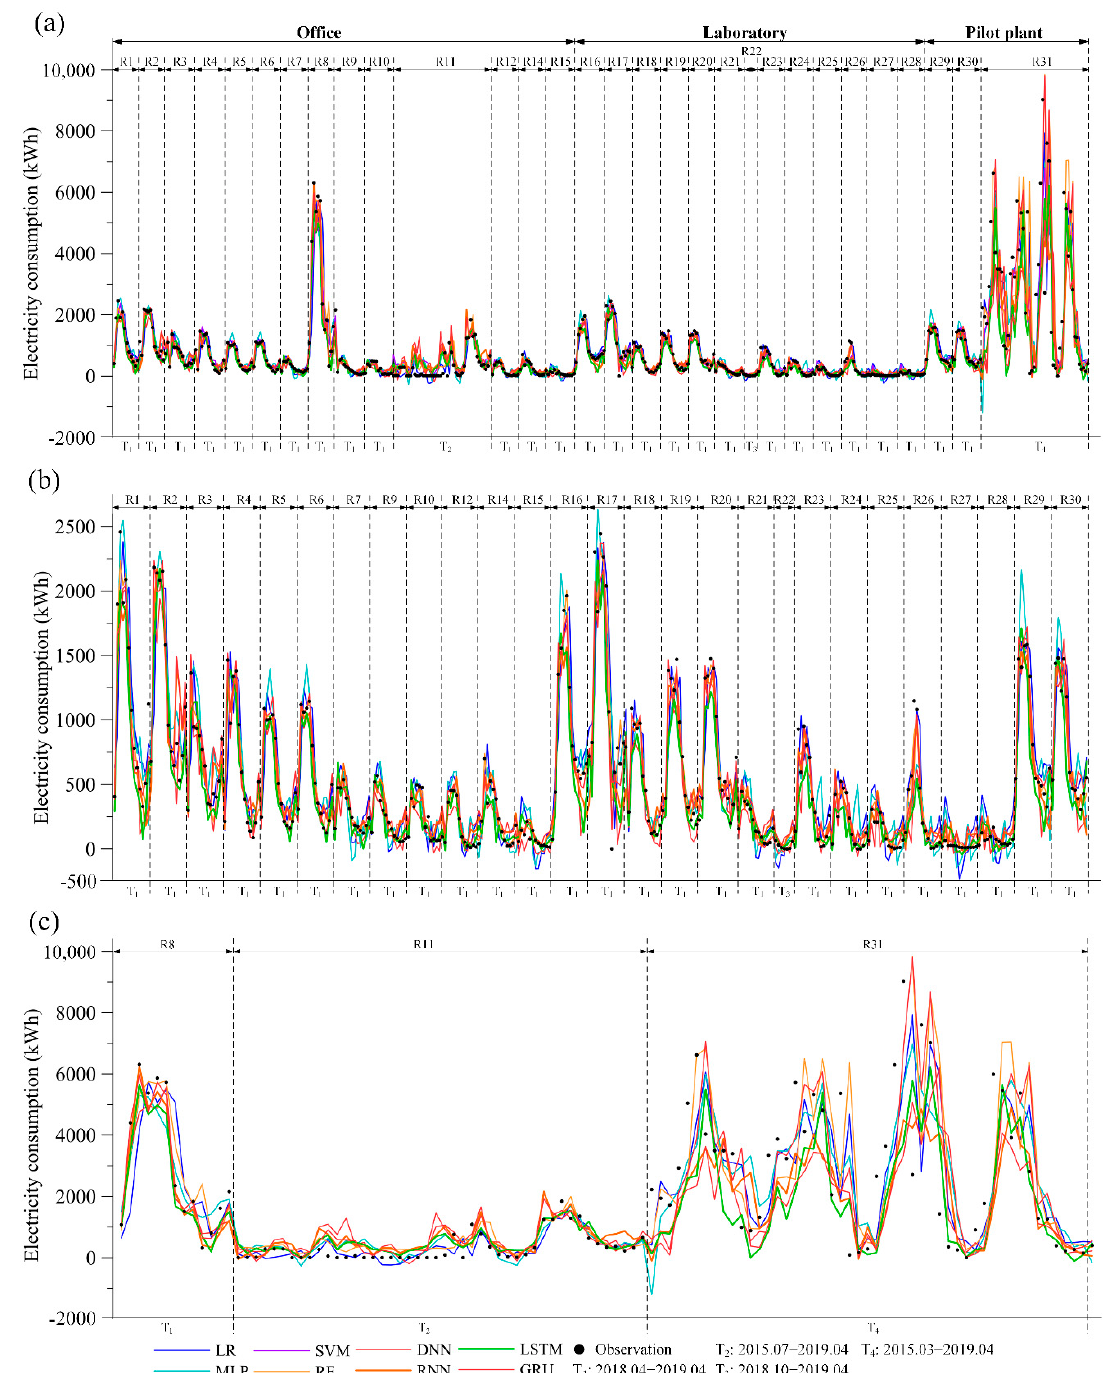
Figure 7. Comparison of the predicted electricity consumption of ( a ) all rooms, ( b ) rooms below 3000 kWh, and ( c ) rooms above 3000 kWh with 1-month-ahead predictions of eight models in the testing phase.